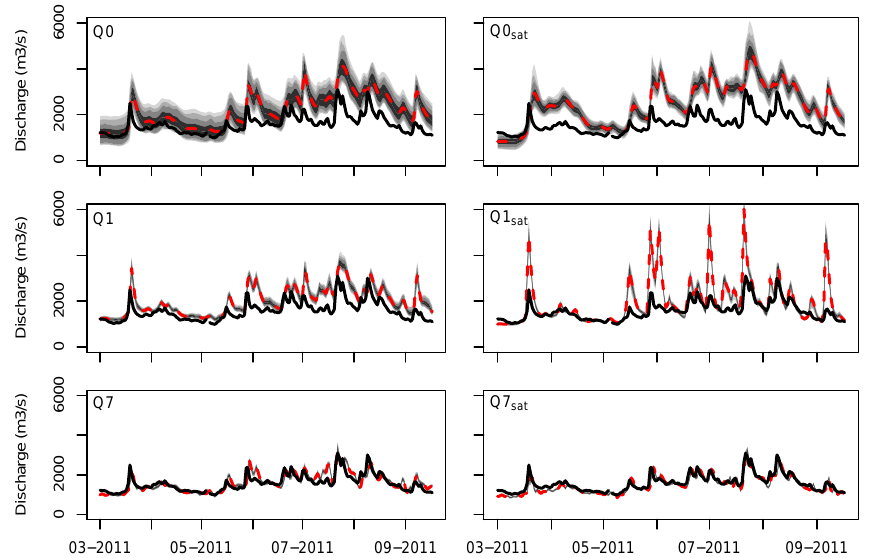
Figure 4. Reanalysis time series of discharge at the outlet of the Upper Danube catchment (Fig. 1) for part of the hindcasting period. In grey are all model realizations, the ensemble mean is given by the red line and the solid black line gives the observed discharge value. The different assimilation scenarios are indicated on the left; for explanation of scenarios see Table 1. The different assimilation scenarios are indicated in the top left corner of each